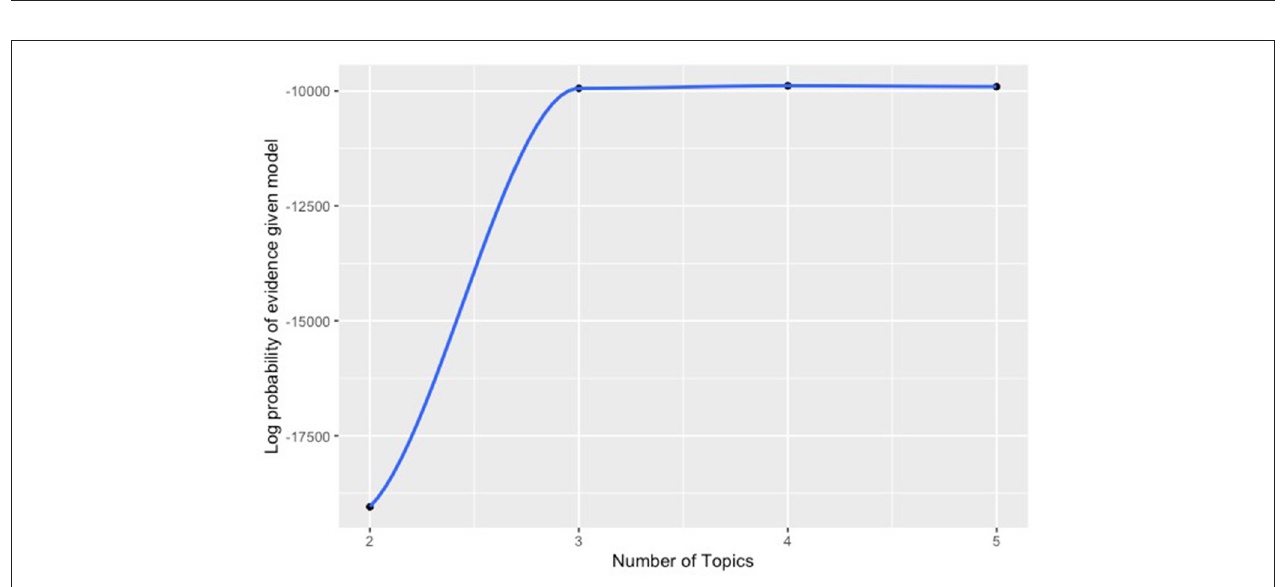
FIGURE 2 | Log posterior probability of the model given the evidence.